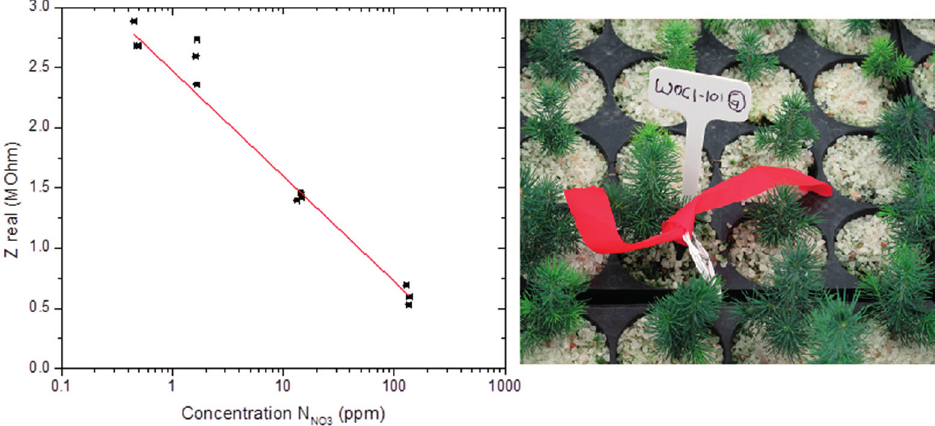
Figure 6. Field test results performed in growing medium selected from a white spruce tree nursery, showing the real part of the measured sensor impedance (in M Ω ) at 1 kHz AC frequency compared against the ISO/IEC 17025-certified colorimetric NO 3 − concentration